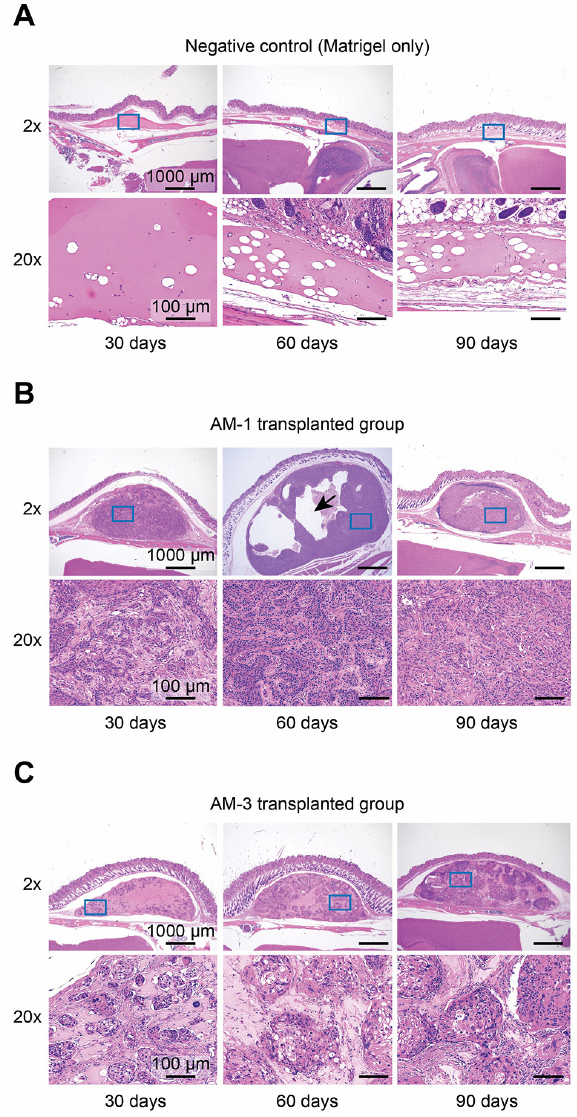
Figure 2- Histological images of H&E staining at each time point: 30, 60, and 90 days. (A) Negative control group: transplanted with Matrigel without cells. (B) AM-1 group: transplanted with AM-1 cells with Matrigel. (C) AM-3 group: transplanted with AM-3 cells with Matrigel. Arrow: Cyst formation at the tumor site in the AM-1 group. Lower panels show the areas marked by blue boxes in the upper panels. Magnification: Upper panels, 2×; Lower panels,